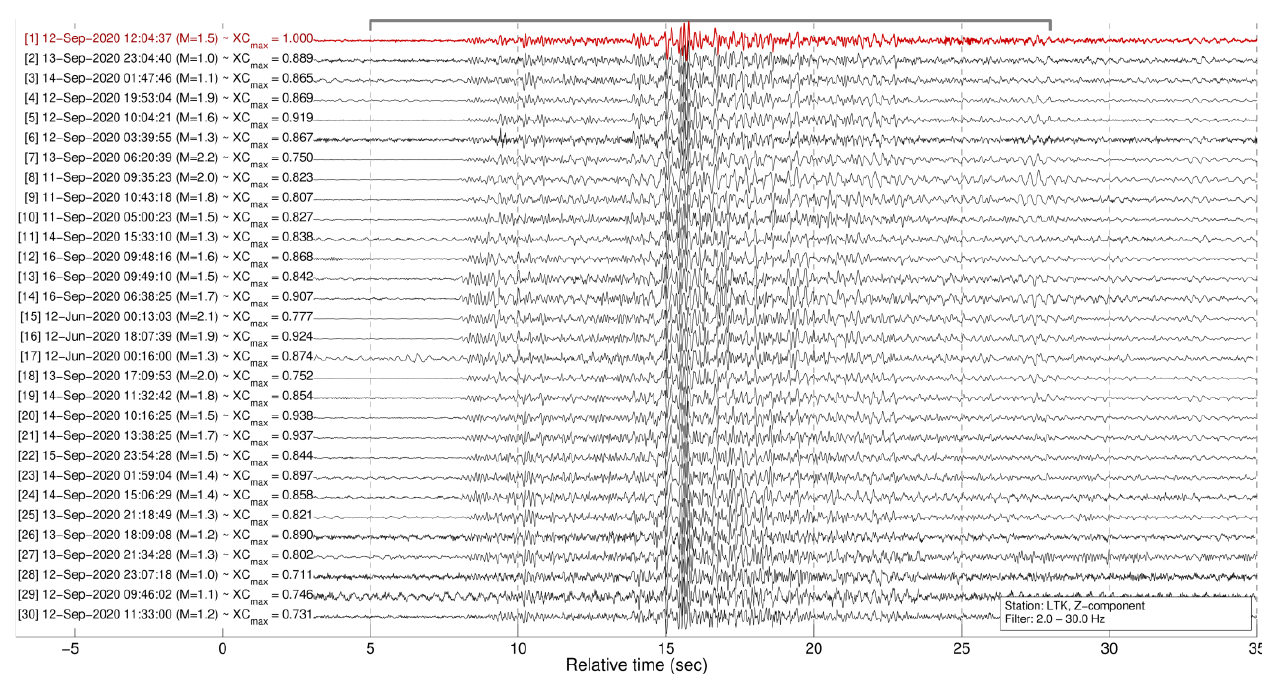
in the window marked with a gray bracket at the top. Note the high degree of similarity (XC max > 0.9) between consecutive pairs.